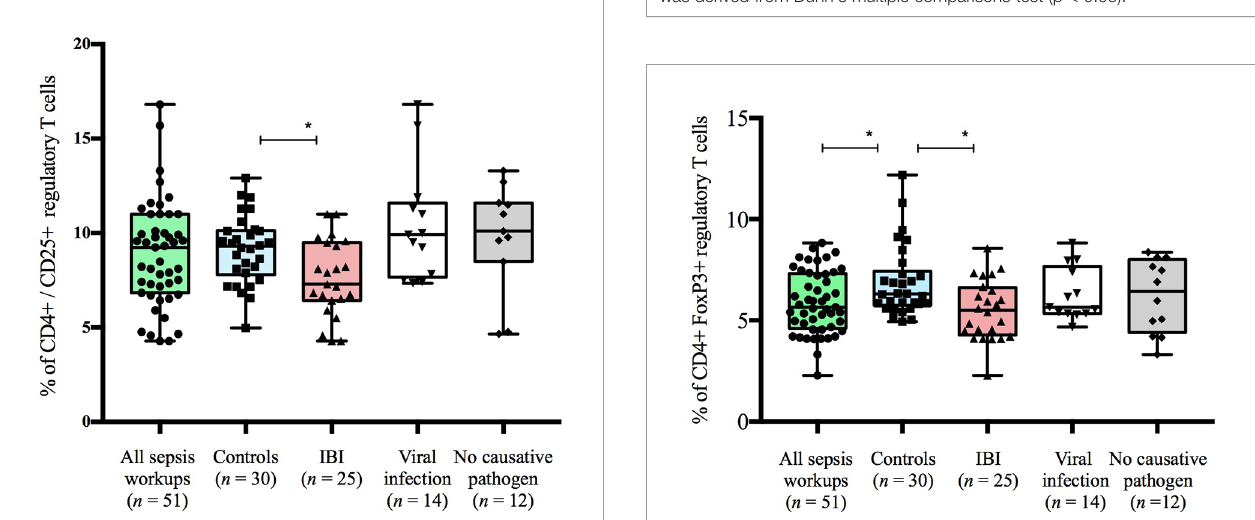
FIGURE 3 | Frequencies of CD4+CD25+FoxP3+regulatory T cells strati fi ed to subgroups of study cohort. Boxes are shown as median and IQR; *p-value was derived from Dunn ’ s multiple comparisons test (p < 0.05).